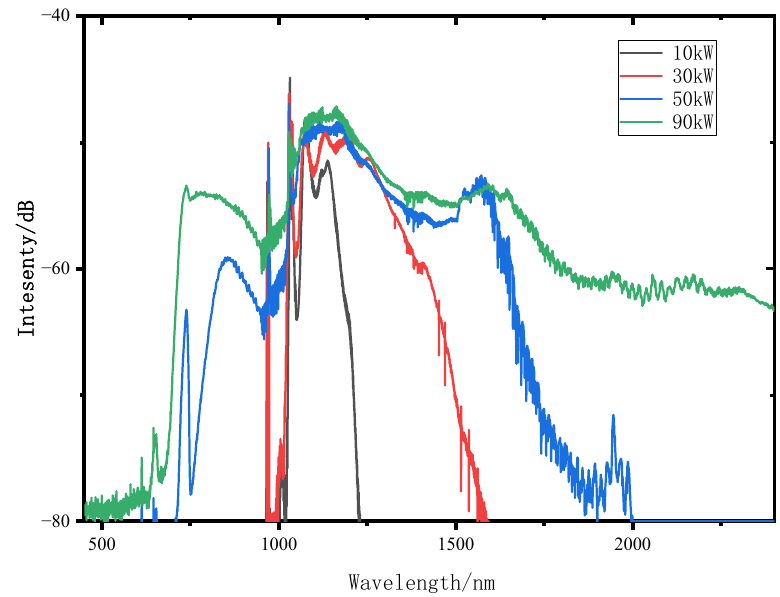
Figure 4. Spectral evolution at different input peak powers after 10 m GRIN fiber.